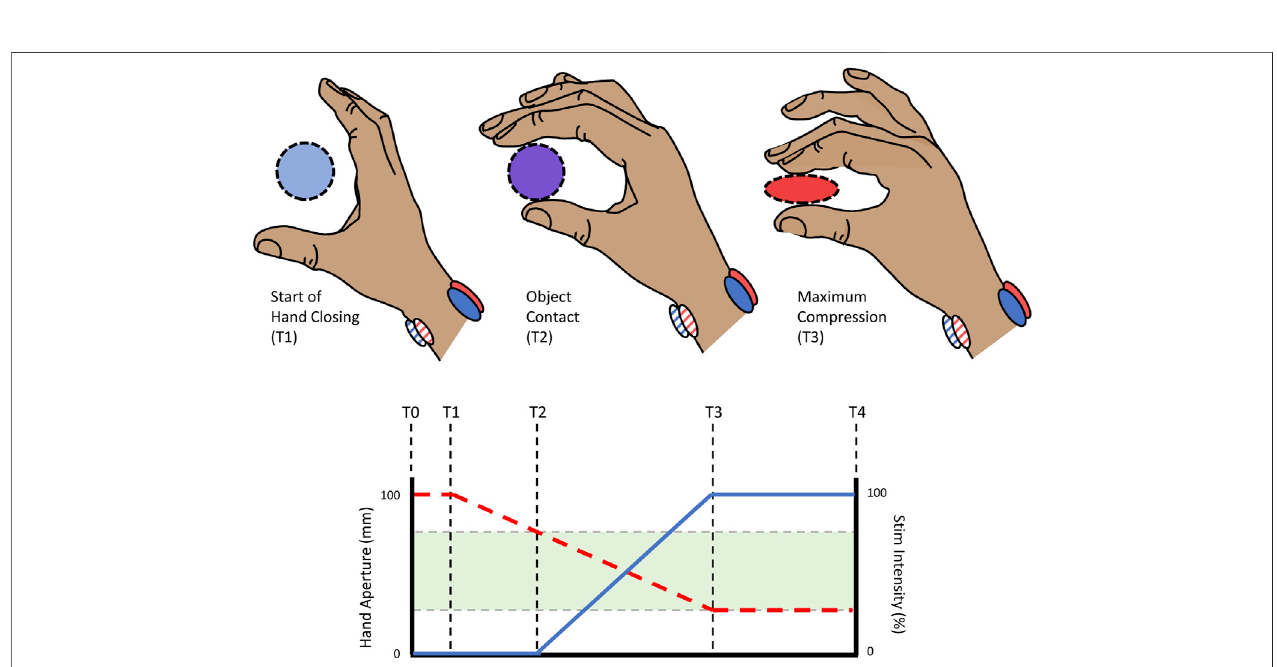
FIGURE 4 | Hand aperture tracking from the start (T0) to the end (T4) of a virtual object exploration attempt. The hand aperture (red dashed trace; left y -axis) was tracked during exploration to determine when the hand made contact with the object (T2) up to the maximum compression of the object (T3). The hand aperture data was used to estimate the resulting grasping force as the user interacted with the object (blue solid trace; right y -axis). The full compressive range of the virtual object (shaded region) was linearly mapped to the full range of stimulation intensities.